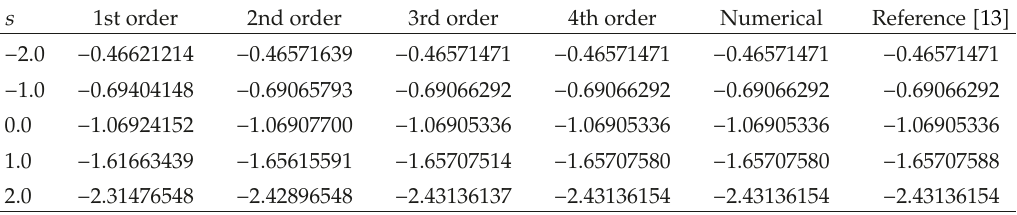
Table 4: Comparison of G (cid:4) (cid:6) 0 (cid:7) at di ff erent orders for the SLM approximations when L (cid:10) 20 ,N (cid:10) 60 against the results of (cid:3) 13 (cid:4) for di ff erent s values when m (cid:10) 1.